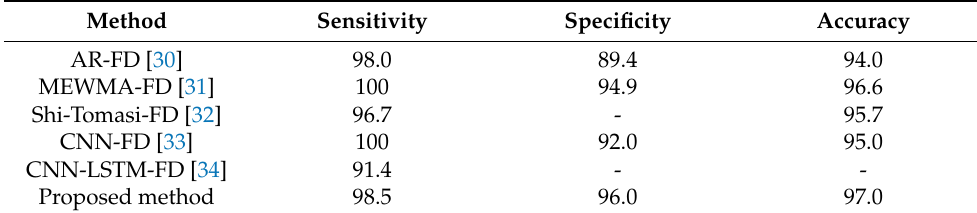
Table 1. Comparison of methods on the UR Fall dataset (%).